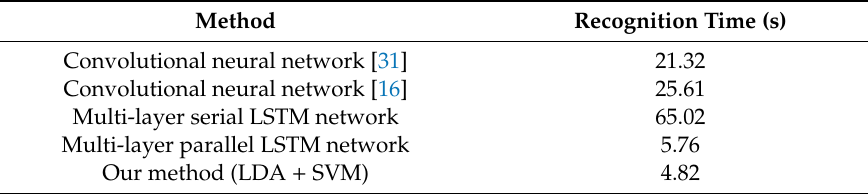
Table 6. Computation complexity.